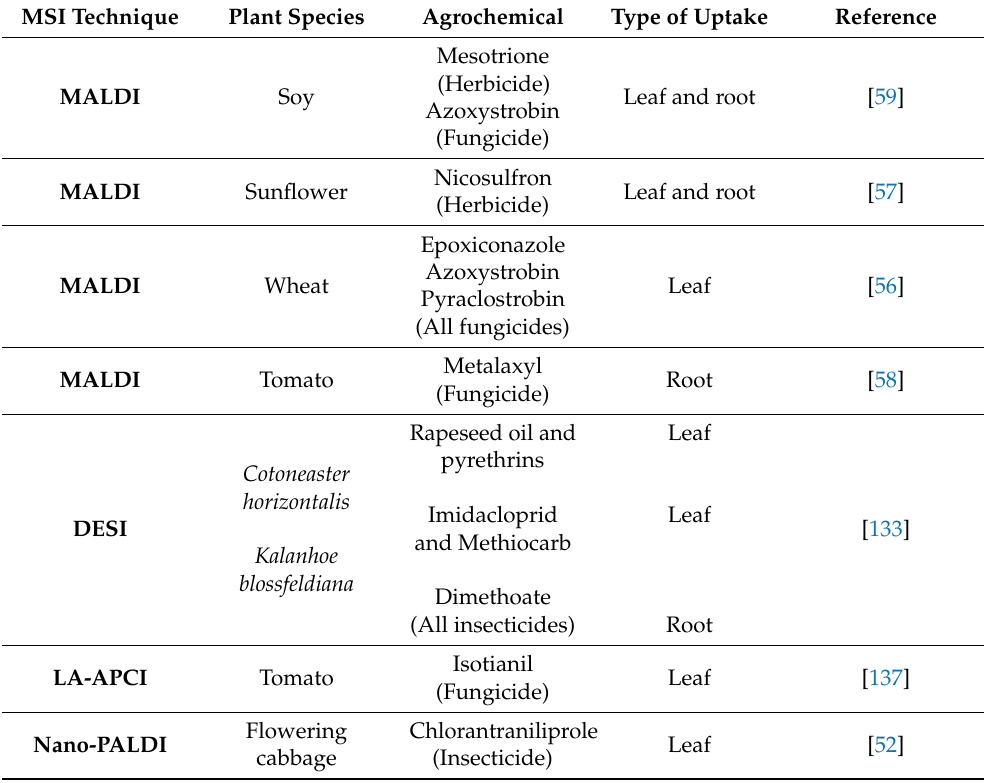
Table 2. MSI studies to image crop-protection products in plant vegetative